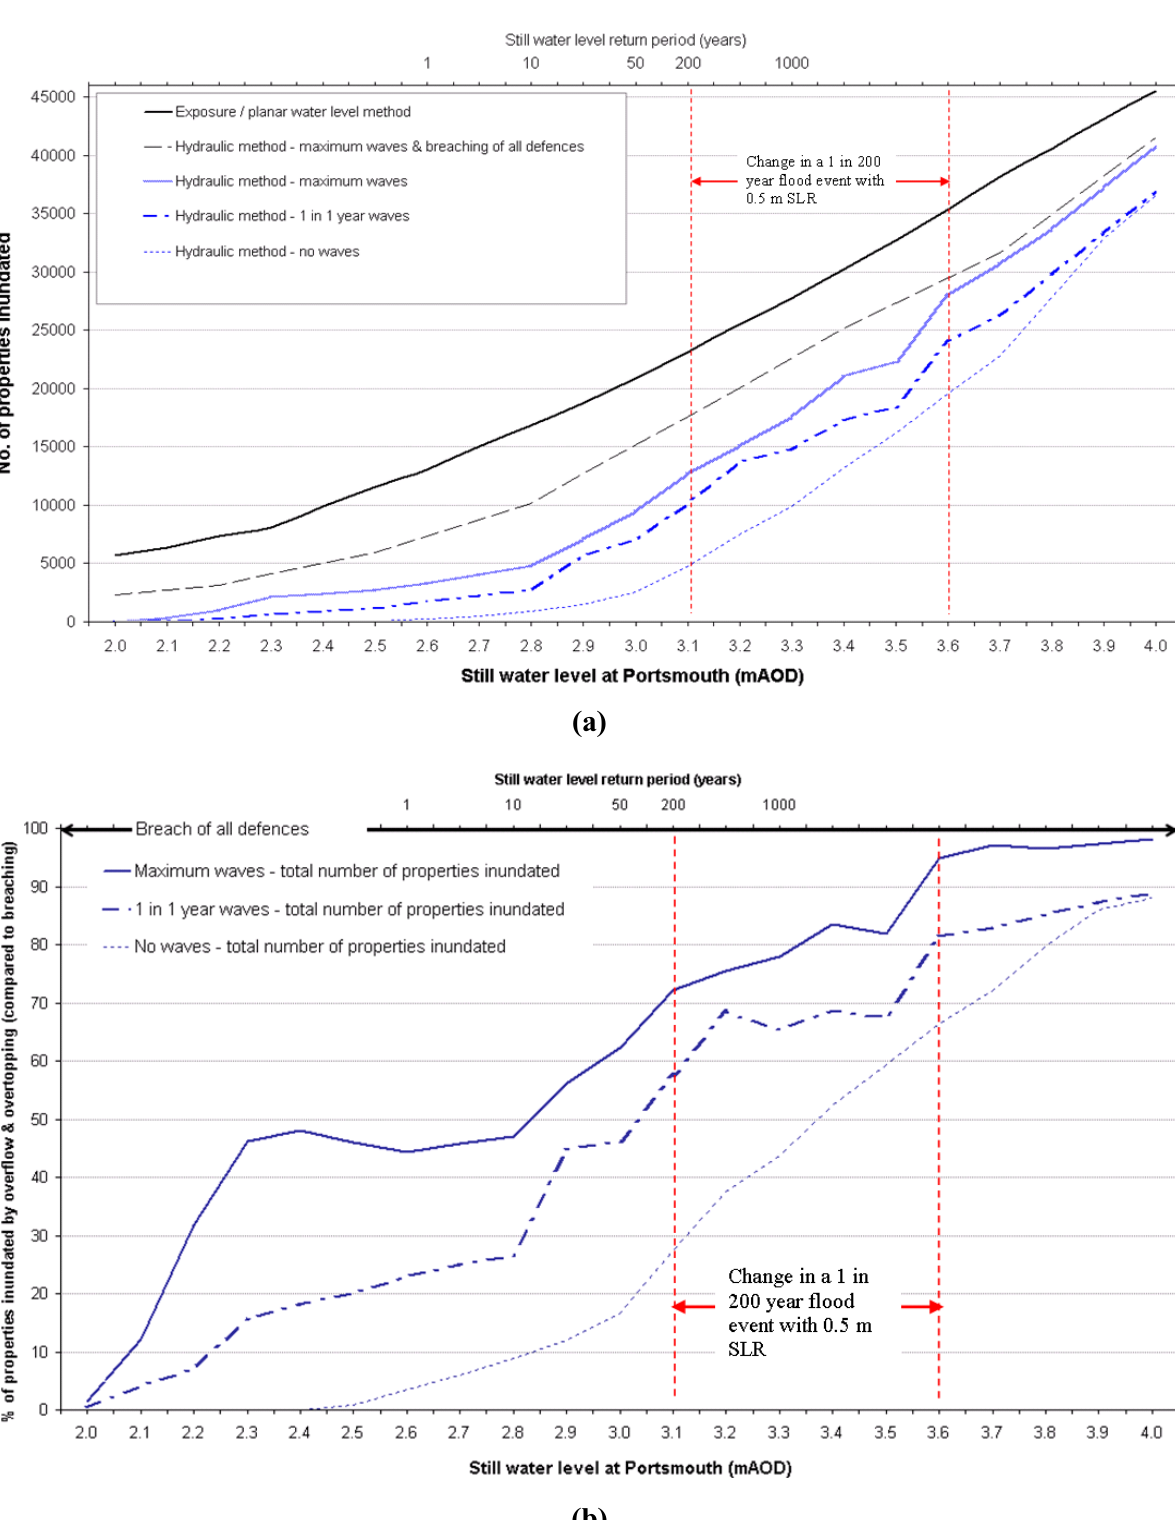
Figure 9. ( a ) Raw inundation modelling results for properties within modelled coastal flood outlines across the Solent–water level return period refers to annual probability of that water level for 2011; ( b ) Percentage of properties inundated by overflow and overtopping defence failures (compared to breach of all